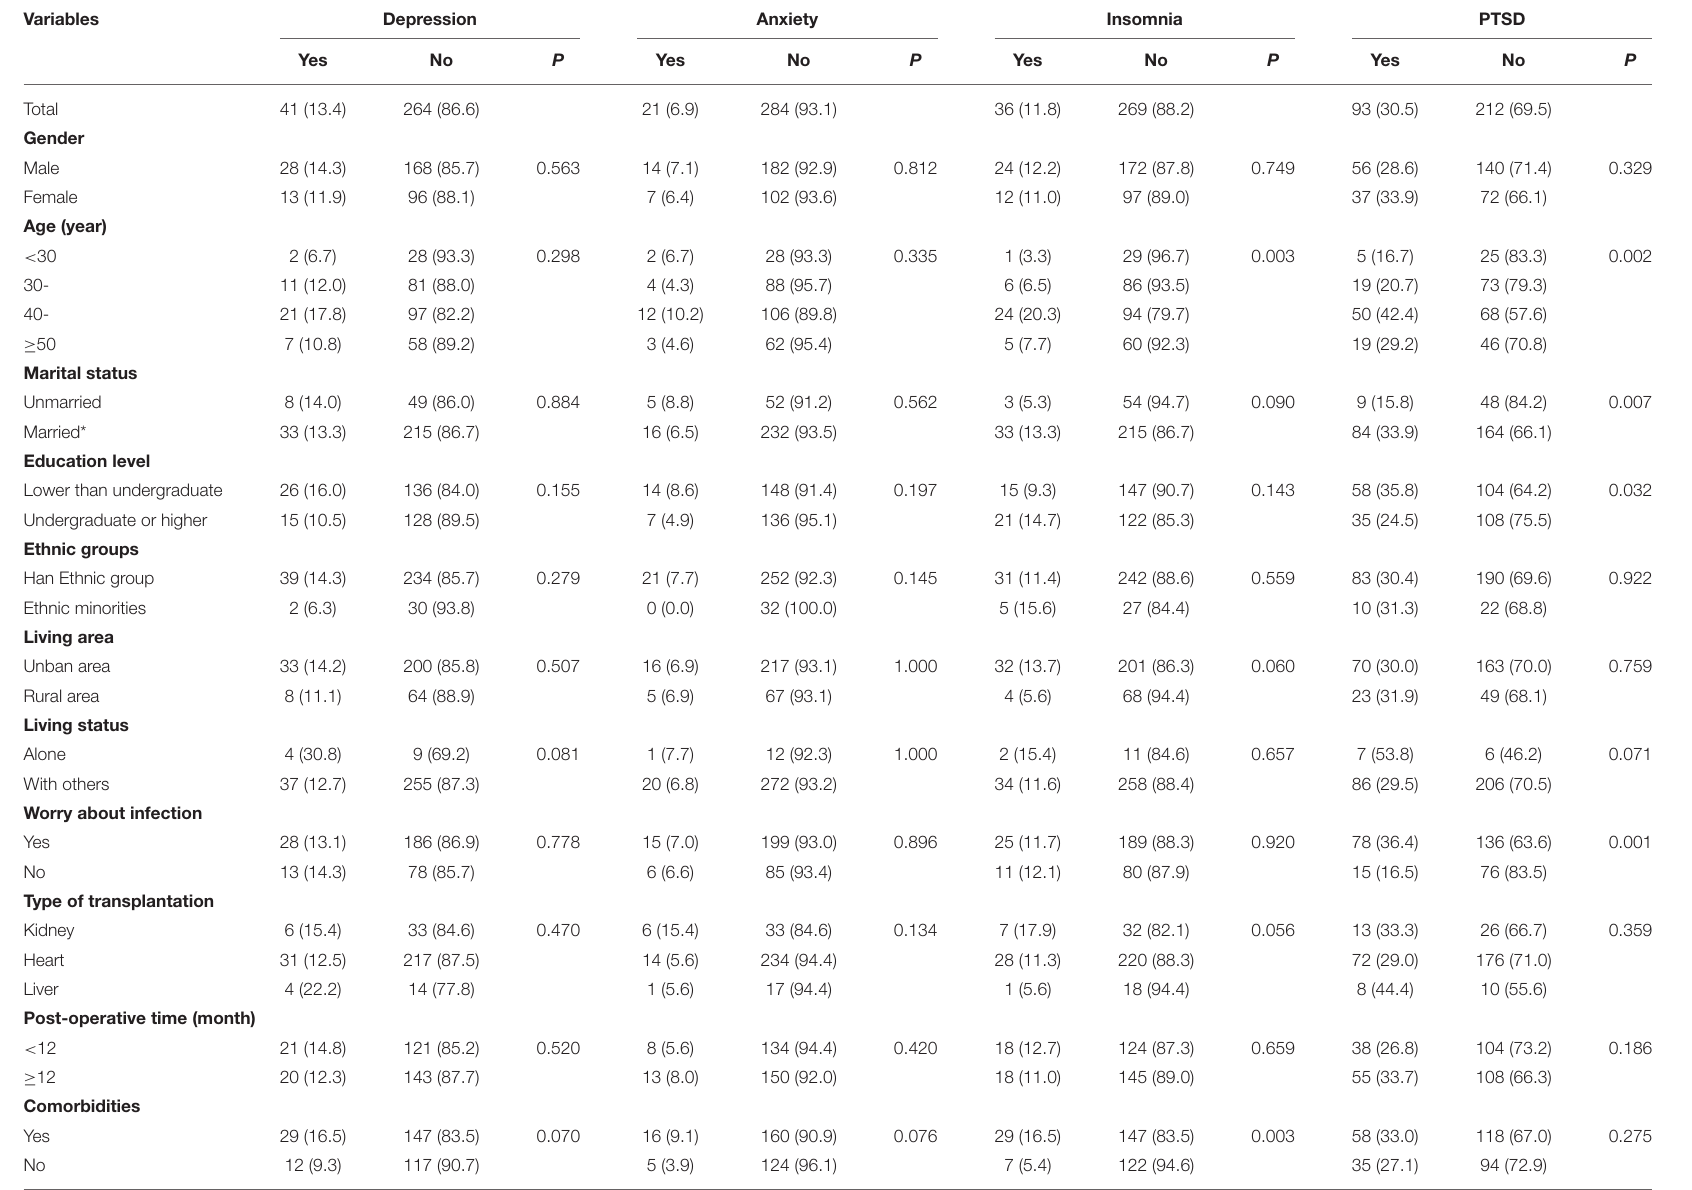
TABLE 2 | Psychological distress in organ transplant recipients during COVID-19 pandemic. Variables Depression